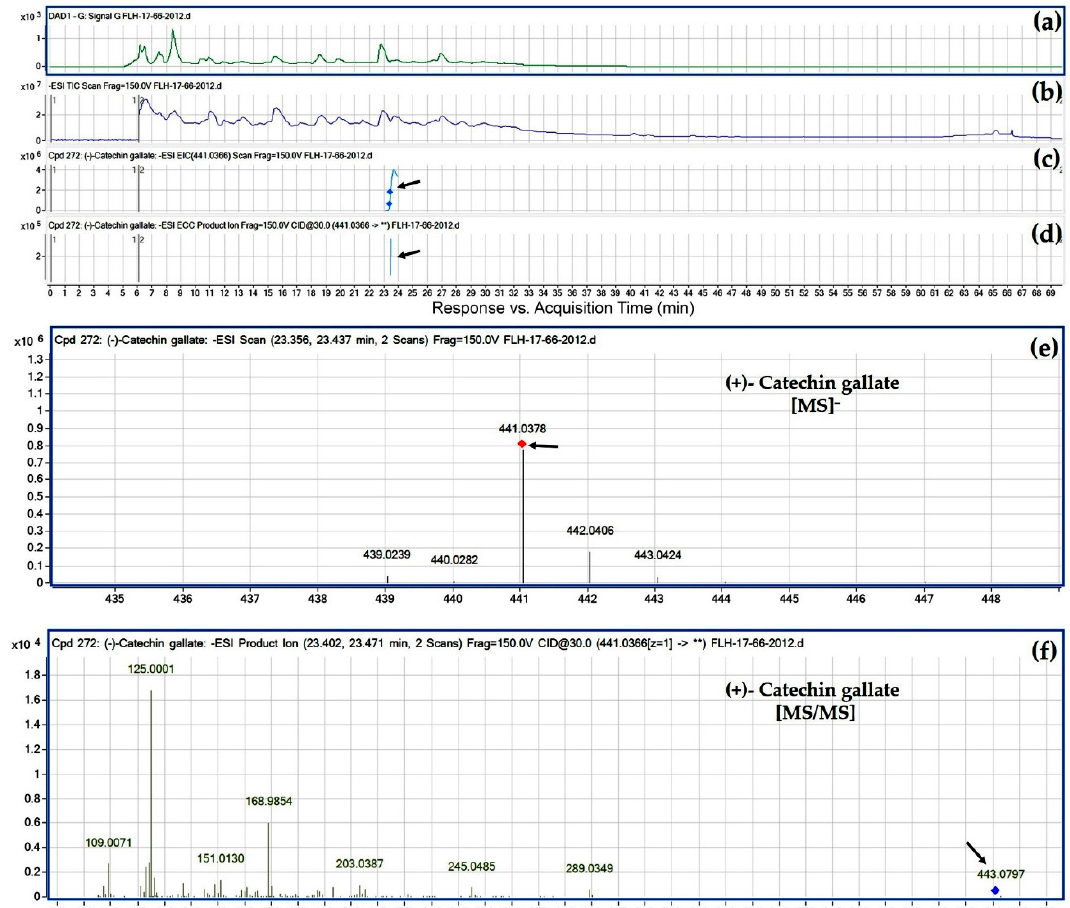
Figure 7. Extracted ion chromatogram (EIC) of primary mass spectrum (MS1) and m / z features of secondary ion fragments (MS2) derived from LC-MC/MS annotate this peak to be (+)-catechin gallate (MW, 442.37). ( a ) Chromatogram of FLH 17-66 extracts (2012) recorded at 280 nm absorbance; ( b ) total ion chromatogram of FLH 17-66 extract (2012); ( c ) EIC of primary ion 441.0366 [M − H]¯; ( d ) enhanced charge capacity (ECC) ion product for m / z 441.0366; ( e ) a MS profile showing an extracted m / z value, 441.0378; and ( f ) fragments from collision-induced dissociation (CID) of m / z 441.0378 showing m / z 109.0071, 125.0001, 136.9989, 151.0130, 179.0047, 245.0485, and 289.0349 (Table 1).